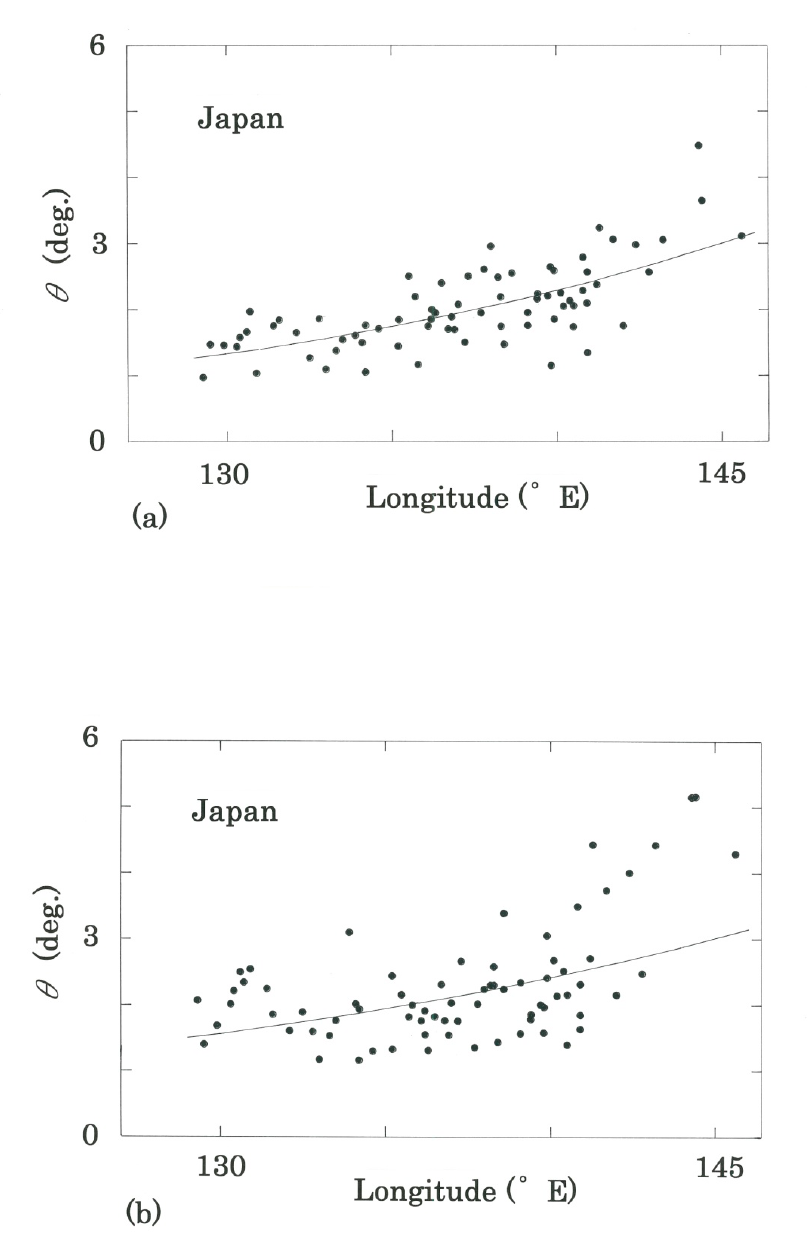
Figure 5. Rotation angles between the monthly distributions of temperatures on the 75 Japanese stations versus their longitudes. ( a ) Rotation from Period I (1931–1960) to Period II (1951–1980) is given. The curve in the plots represents the optimal exponential regression ( r = 0.648 with d = 1.930 > d U = 1.50 for n = 75). ( b ) Rotation from Period II (1951–1980) to Period III (1981–2010). The curve in the plots represents the optimal exponential regression ( r = 0.511 with d = 1.120 < d L = 1.45 for n = 75).